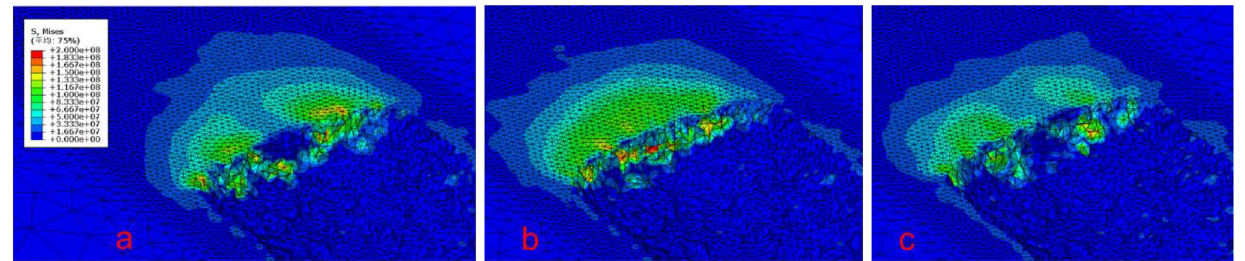
Fig. 17 Stress distribution of the rock section at different stages under the action of the 3D concave-shaped